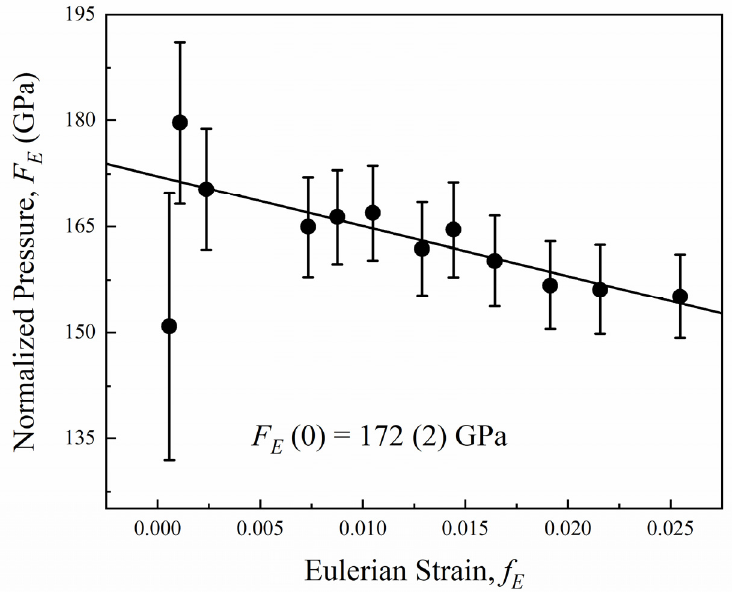
Figure 3. Volume Eulerian strain–normalized pressure ( F E – f E ) plot. The solid line is the linear fit of the data.